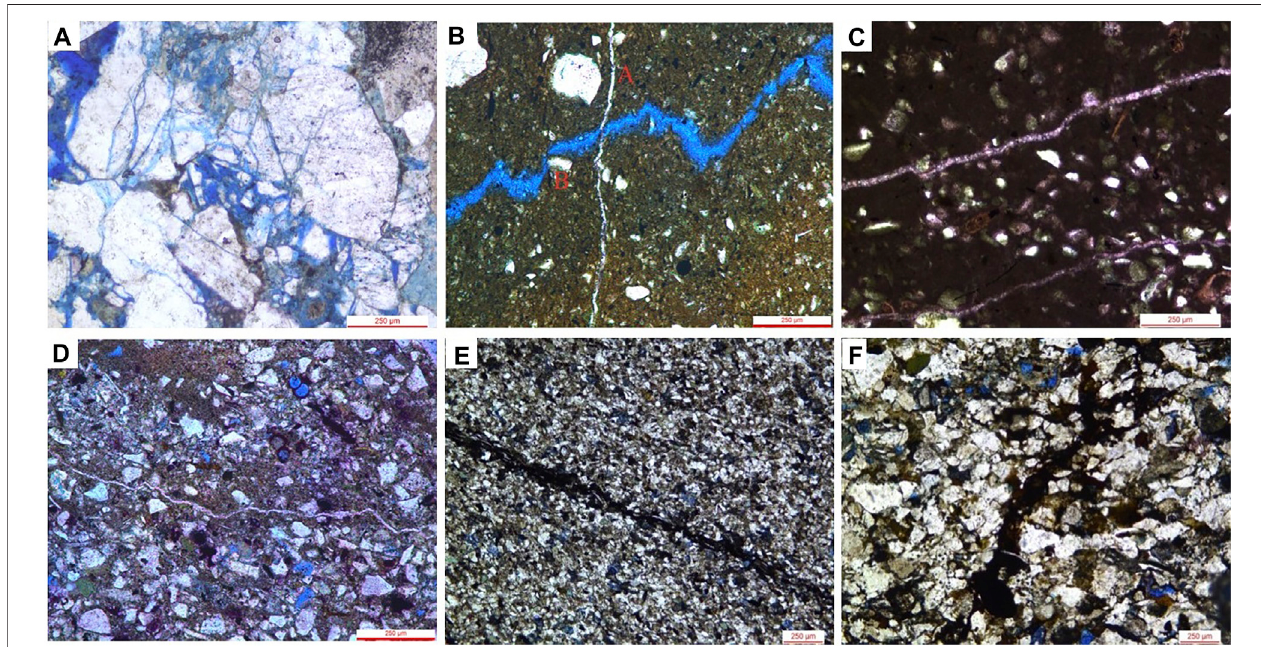
FIGURE 7 | Fractures in the thin sections of low-permeability sandstone reservoirs in the LD-A gas fi eld. (A) Un fi lled shear fracture in well LD-A-2-1, depth 4,093.70 m, (B) shearfractureinwellLD-A-1-1,depth3,785.56 m,thefractureBiscutupbyfractureA, (C) fi lledshearfractureinwellLD10-1-1,depth4,083.05 m, (D) diagenetic fractures in well LD-A-1-1, depth 2,235.50 m, (E) microfractures in well LD-A-1-1, depth 3,675.25 m, and (F) fracture fi lled with asphalt in well LD-A-1-1, depth 4,107.05 m.